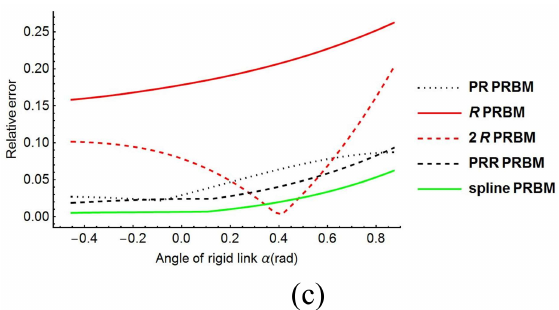
Figure 14. Length results ( a ), angle results ( b ), and relative errors ( c ) of PRBMs.